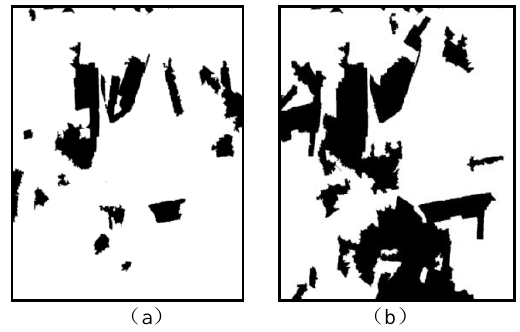
Figure 8. The results of change detection, (a) a=1, b=0, (b) a=0,